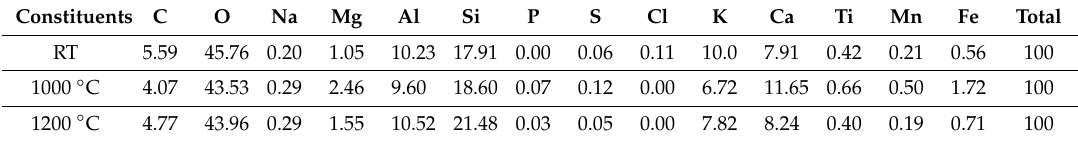
Figure 9. XRD patterns of ( a ) metakaolin-based geopolymer and ( b ) basalt fiber at different elevated temperatures. Table 4. Chemical element composition of the sample S3 at di ff erent temperatures (wt.%). Constituents